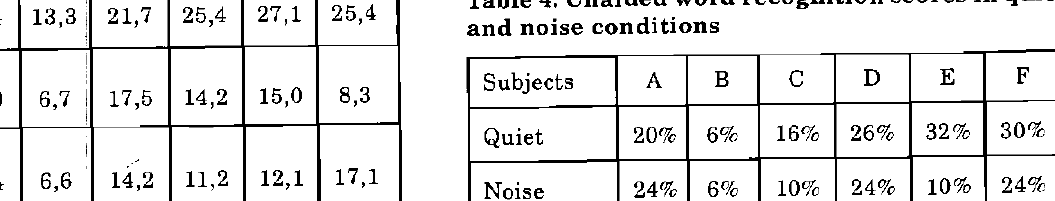
Table 4. Unaided word recognition scores in quiet